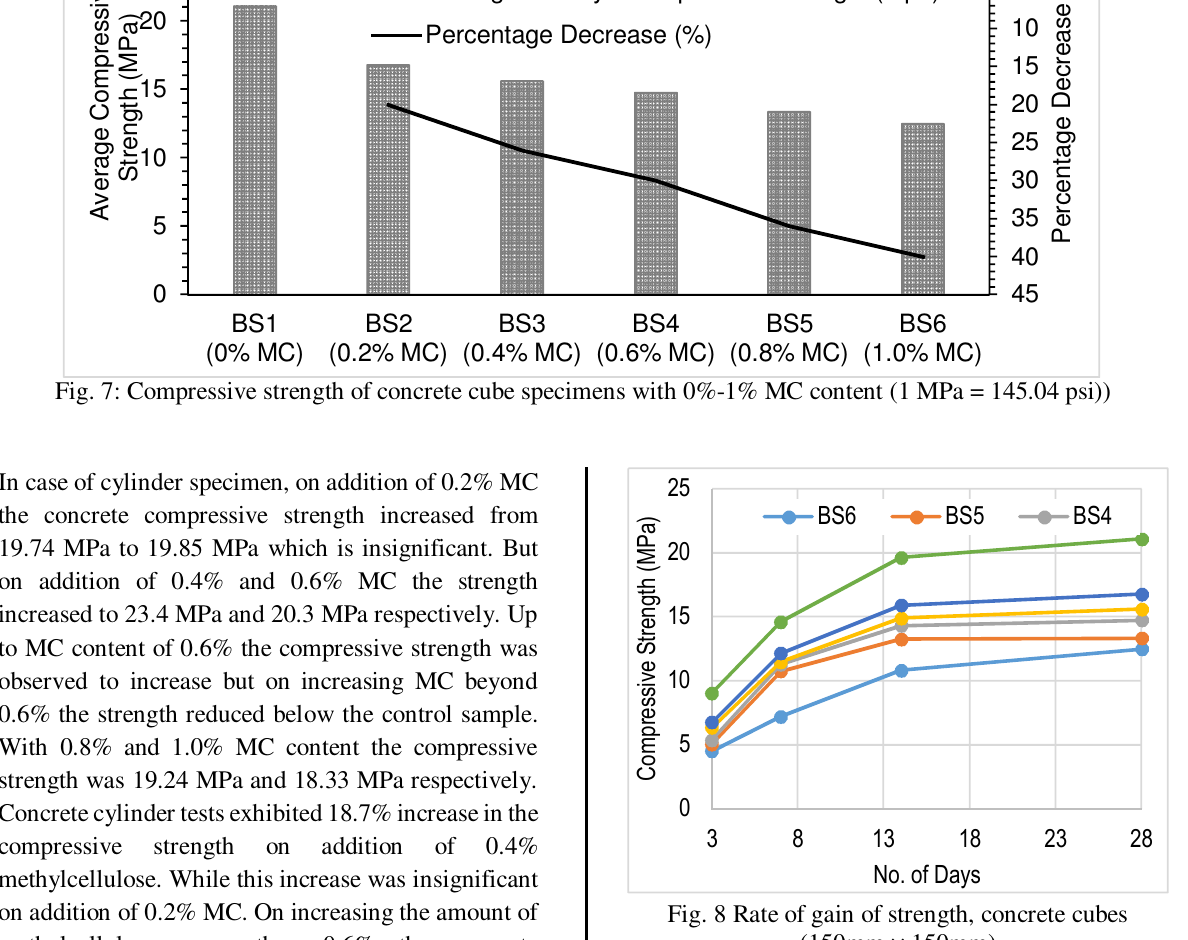
Fig. 8 Rate of gain of strength, concrete cubes (150mm ×